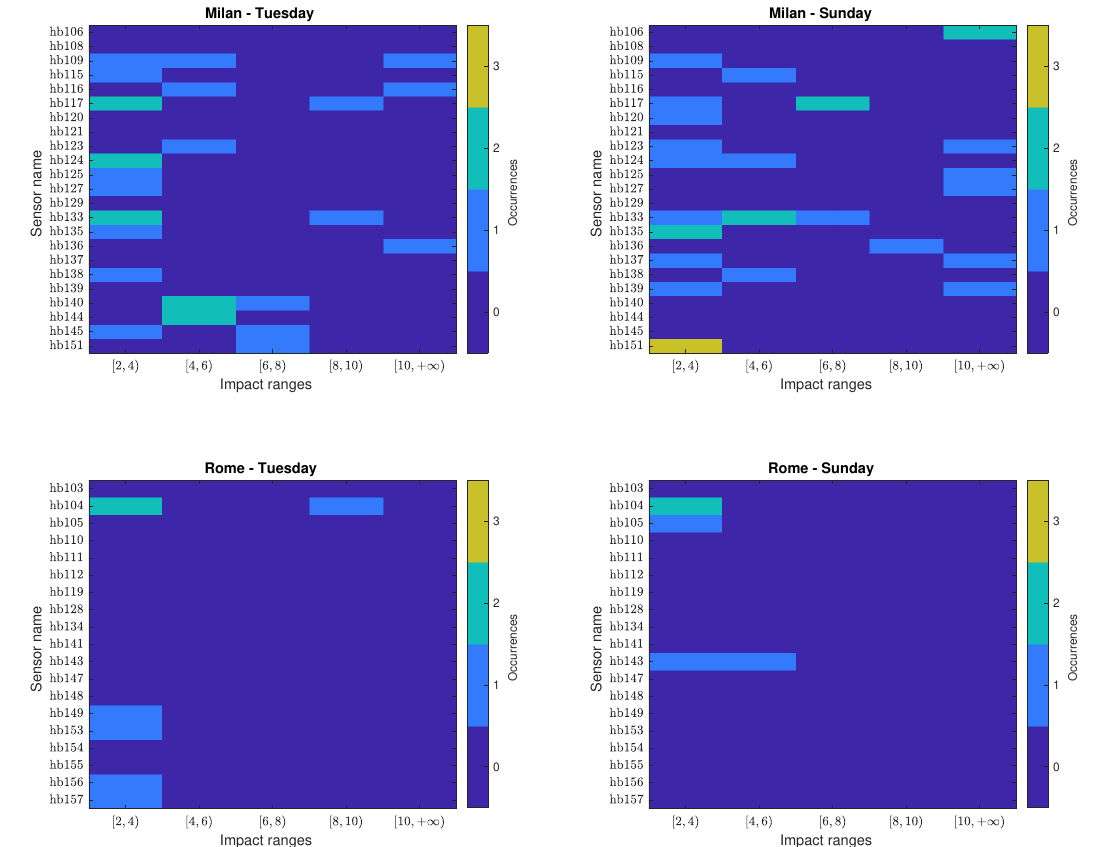
Figure 5. Critical AI histogram matrices ( H c ) of individual ANEs for the urban (Milan) and suburban (Rome) environments obtained from a weekday (Tuesday) and weekend day